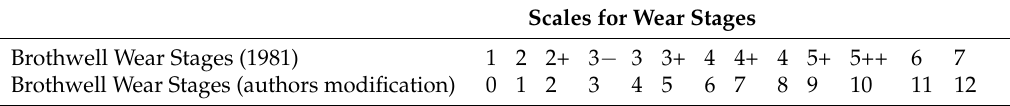
Table 1. Modification of Brothwell tooth wear.